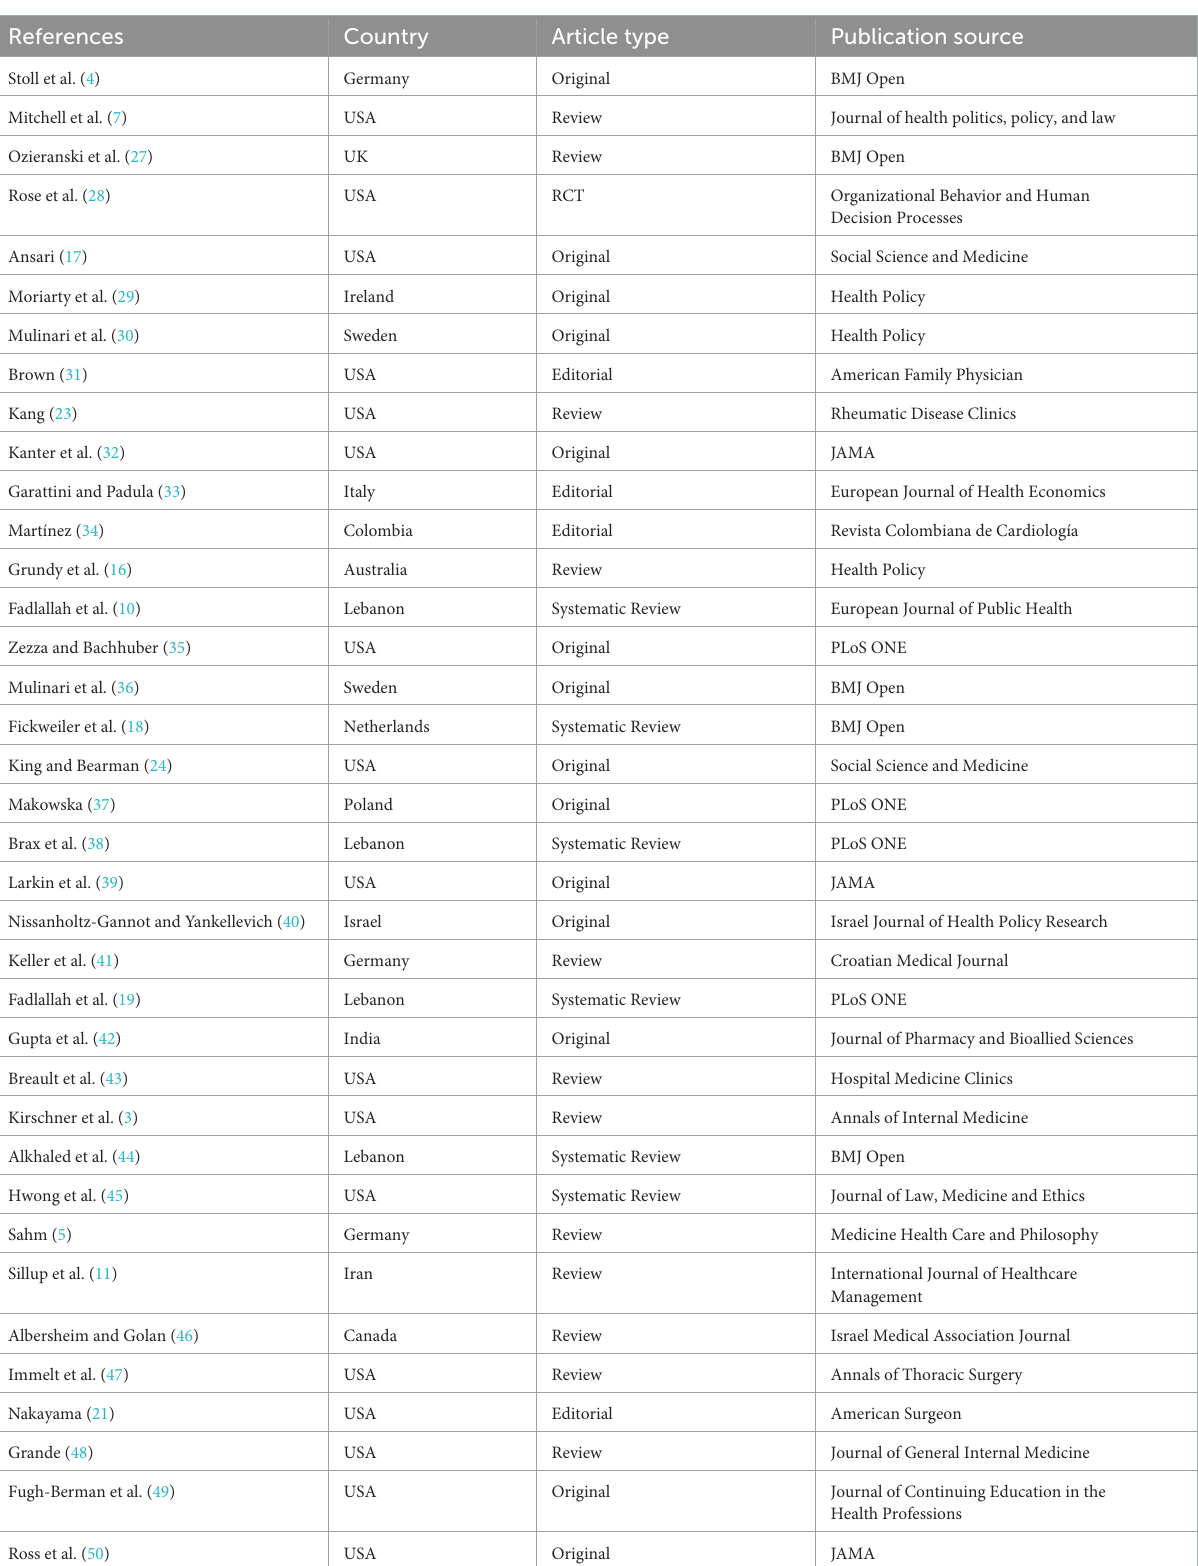
TABLE 1 Characteristics of included